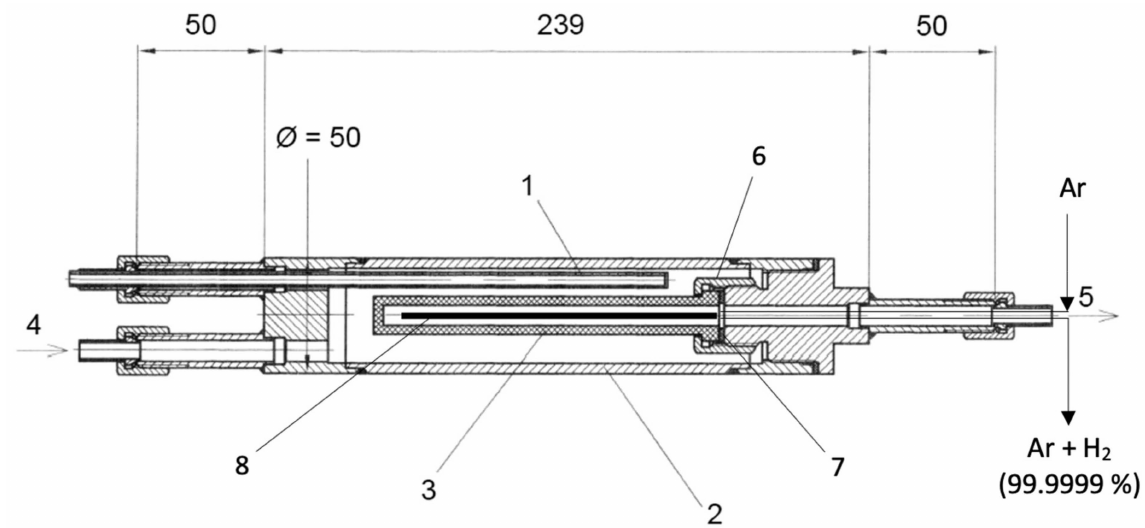
Figure 3. Design of catalytic membrane reactor (the dimensions are in mm). Designations: (1) ther- mocouple pockets; (2) reactor vessel; (3) porous catalytic converter; (4) feed supply; (5) outlet for total reaction products; (6) clamping nut; (7) graphite gasket; (8) hydrogen-selective membrane made of palladium alloy (in the hybrid version of the